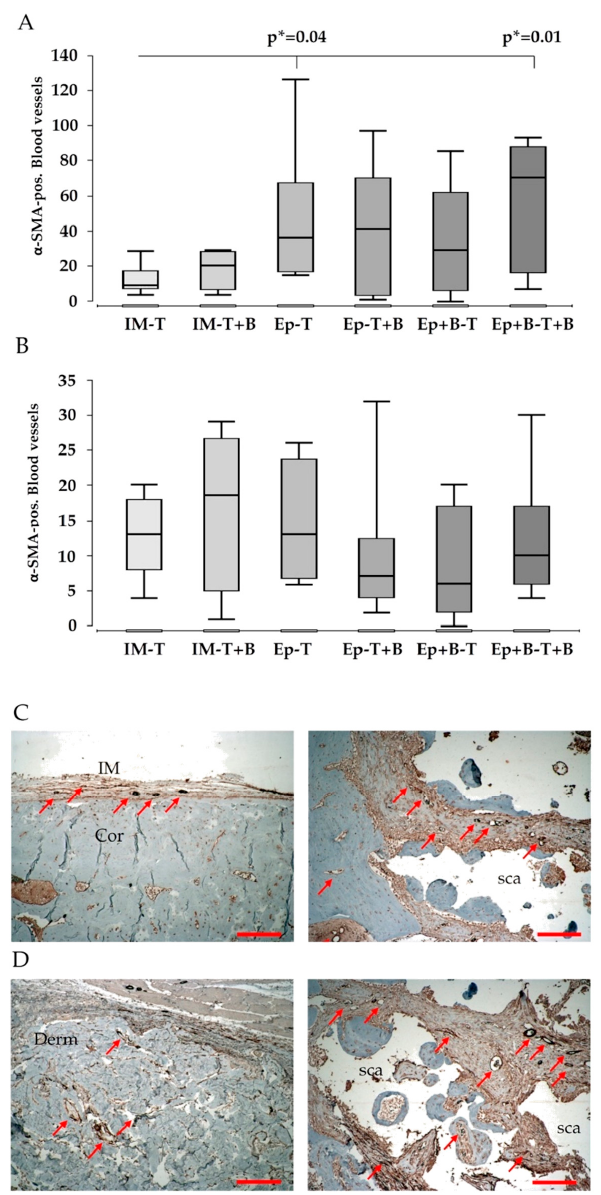
Figure 6. Evaluation of vascularization based on immunostaining of established blood vessel, using antibodies directed against α -SMA within the whole defect ( A ) and the induced membrane and decellularized dermis ( B ). Representative images of bone defects treated with an induced membrane ( C ) or decellularized dermis ( D ). Left images show the area of the induced membrane, respectively, of dermis, right images depict central defect areas. Notably, α -SMA-positive blood vessel in acellular dermis were predominantly seen in peripheral regions of the dermis in close vicinity to muscle, whereas α -SMA-positive vessels were generally not detectable in central portions of the decellularized dermis independently from the presence/absence of BMC within the dermis. In some cases, α -SMA-positive vessels, probably originating from muscle, were penetrating the acellular dermis. Moreover, α -SMA-positive vessels in the induced membrane were oftentimes more pronounced (established) compared to the decellularized dermis. p * = uncorrected p-value, indicates a statistical trend. Red arrows indicate α -SMA-positive blood vessels, Cor = corticalis, Derm = decellularized dermis, IM = induced membrane, sca = scaffold. Size bar indicates a distance of 200 µ